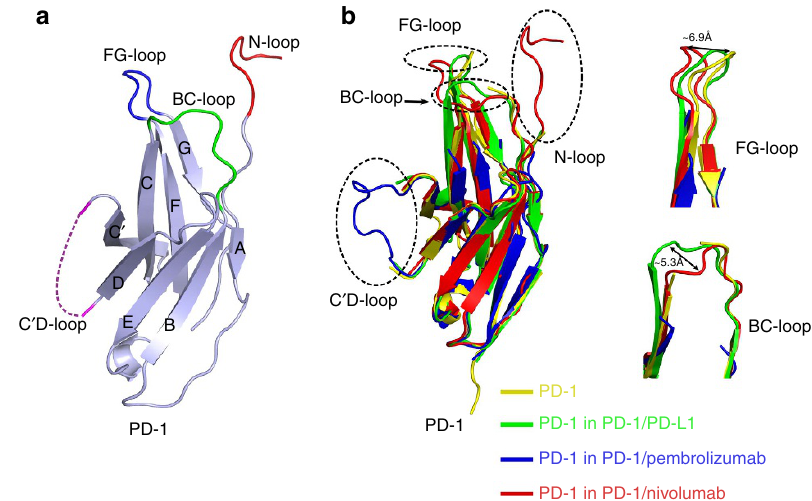
Figure 7 | Targeting the loops of PD-1 for monoclonal antibody-based immune checkpoint blockade. ( a ) The loops of PD-1 targeted by nivolumab or pembrolizumab are coloured differently as follows, N-loop, red; BC loop, green; FG loop, blue; C’D loop, magenta. ( b ) Comparison of PD-1 with other solved PD-1 structures with/without ligands (apo structure, yellow, PDB: 3RRQ; PD-1/PD-L1 structure, green, PDB: 4ZQK; PD-1-pembrolizumab-Fab structure, blue, PDB: 5JXE; PD-1-nivolumab-Fab structure,